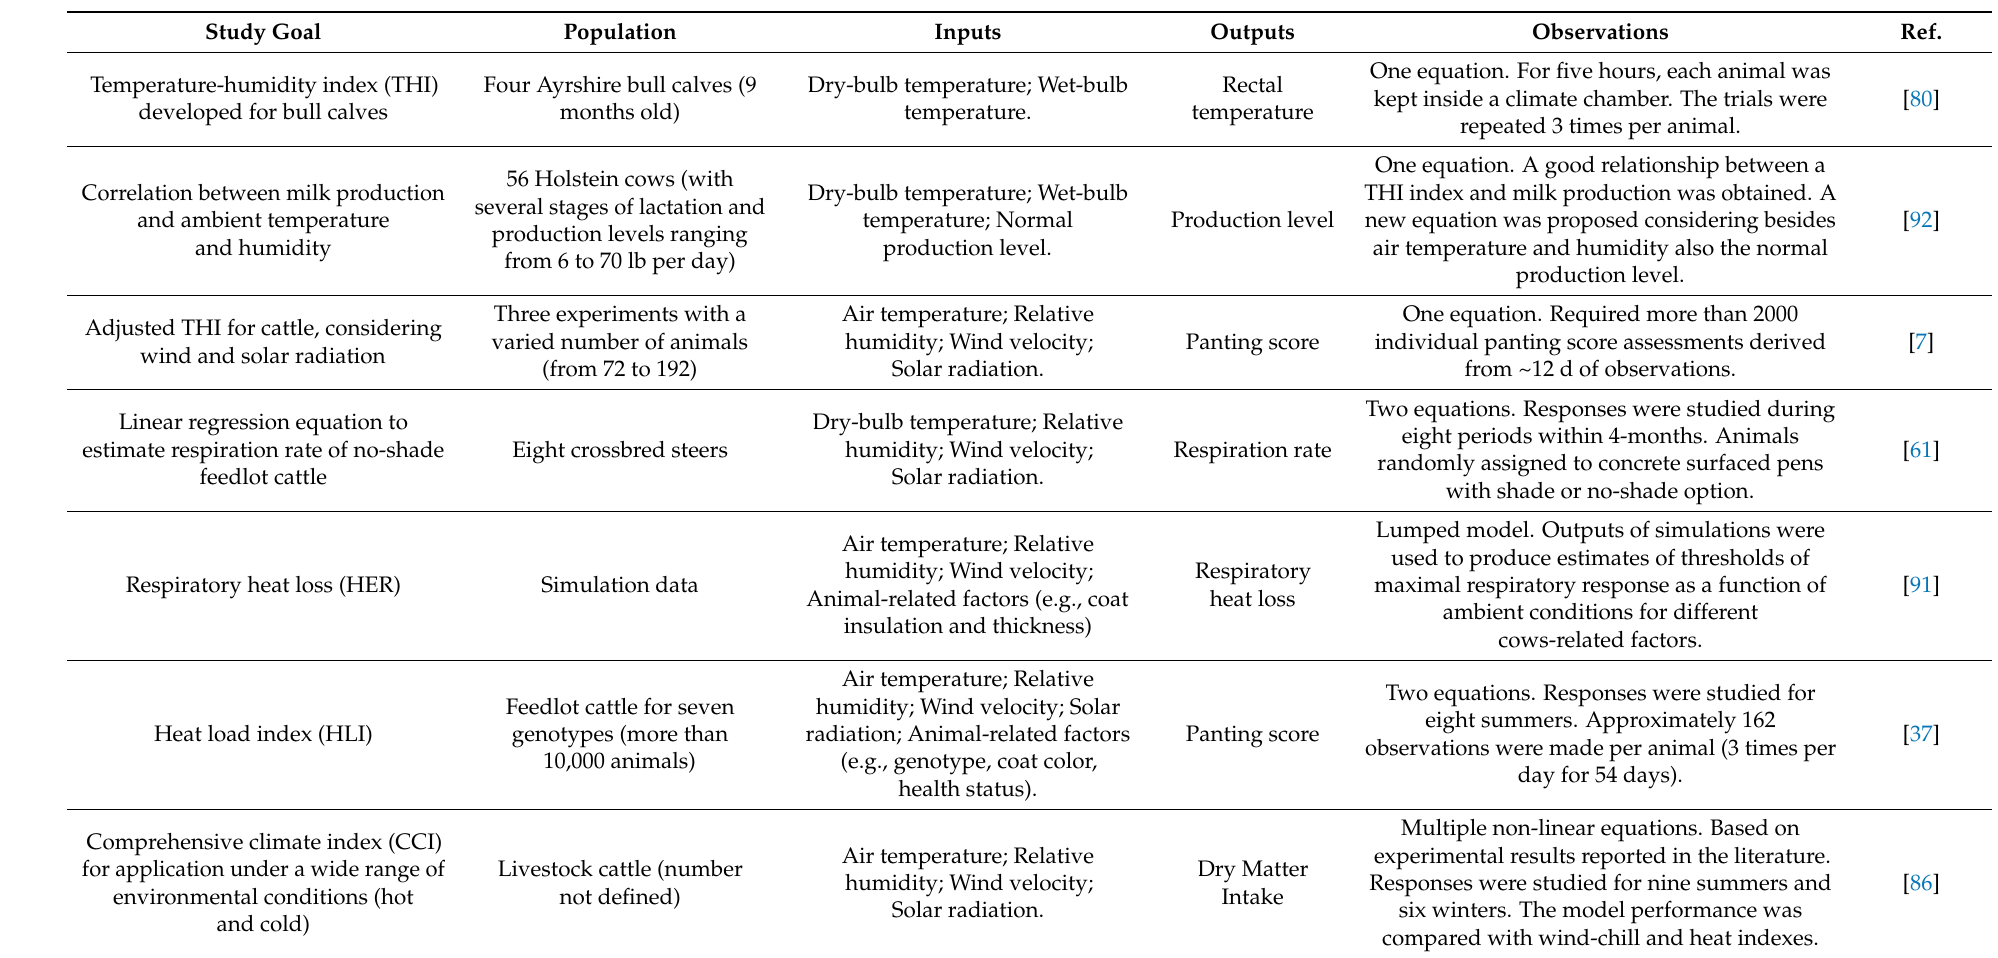
Table 1. Example of bioclimatic indexes and the corresponding input and output